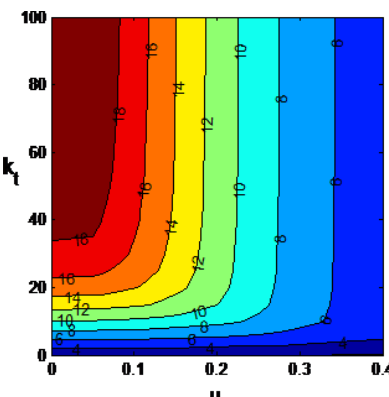
Figure 6. Contour plot of the buckling load p ( q = 0) with respect of k t and µ with k r0 = 10 8 (clamped at x = 0), k r1 = 0 (hinge at x = L ).